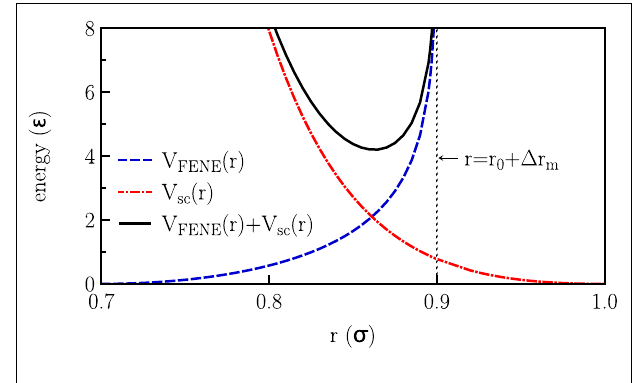
FIGURE 1 | Interactions applied in the model .